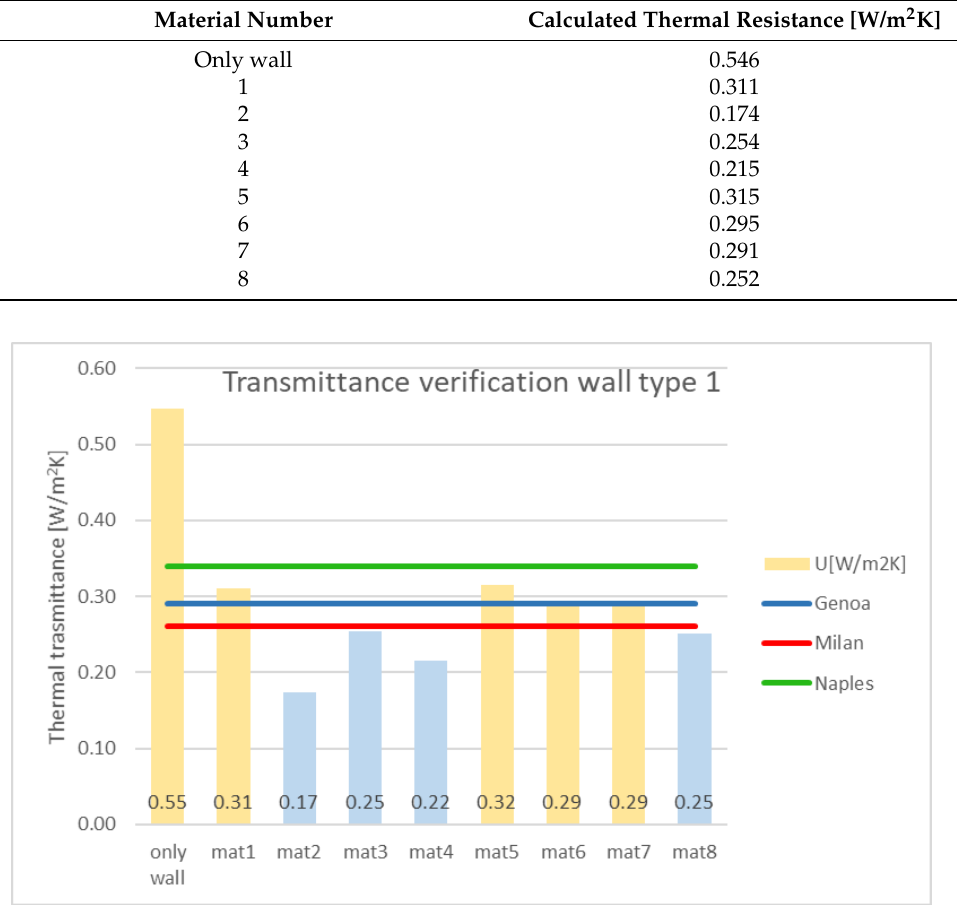
Figure A2. Wall type 1: transmittance check for the three main Italian climatic zones. In blue are the heat-reflective materials which respect all the limits.